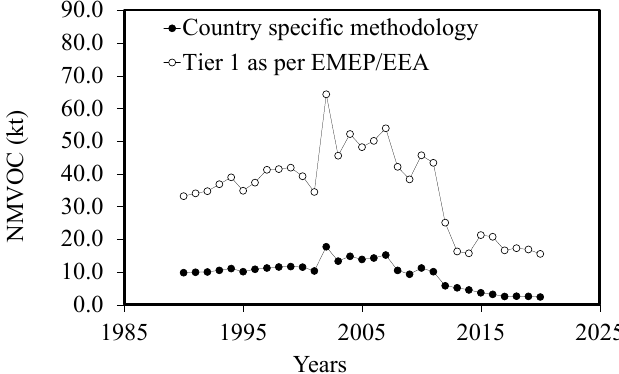
Figure 5. NMVOCs emissions from other solvent use.